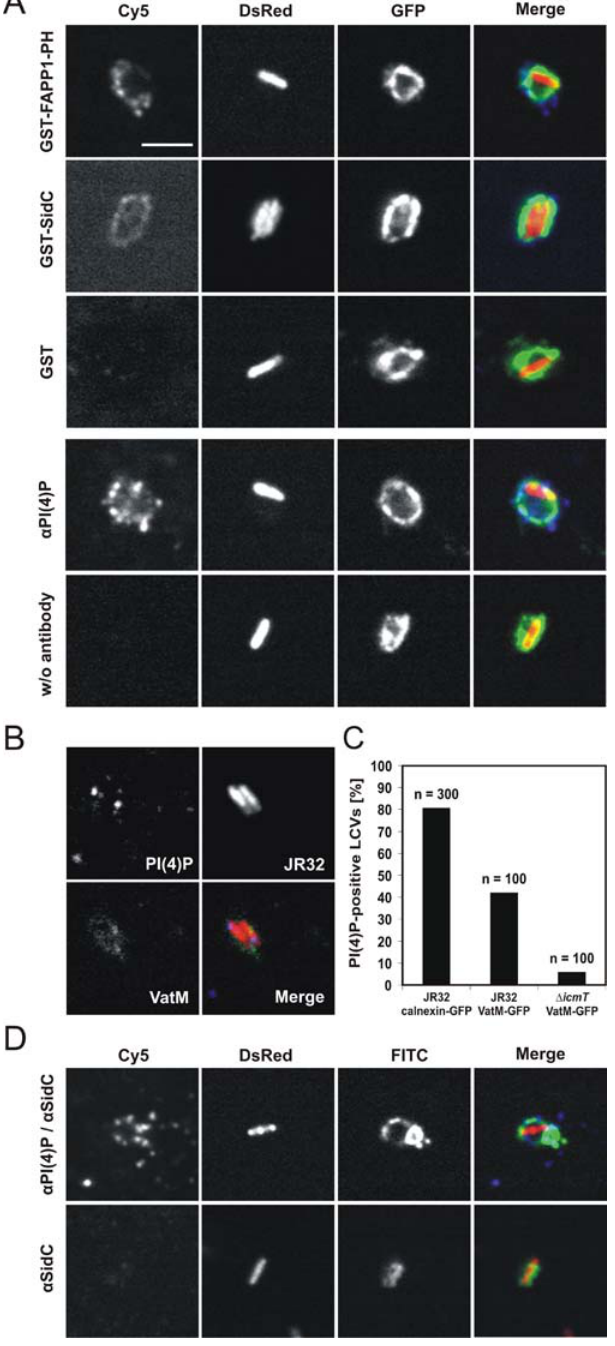
Figure 7. PI(4)P Is a Lipid Marker of LCVs Harboring Icm/Dot–Proficient L. pneumophila (A, B, and D) Confocal micrographs of LCVs in lysates of (A) calnexin-GFP– labeled Dictyostelium, (B) VatM-GFP–labeled Dictyostelium, or (D) RAW264.7 macrophages infected with DsRed-Express–labeled L. pneu- mophila are shown. The lysates were prepared with a ball homogenizer, and PI(4)P was visualized on the LCVs using as probes either the PH domain of the PI(4)P-binding protein FAPP1 fused to GST, an antibody against PI(4)P, or GST-SidC. Using GST alone or omission of the anti-PI(4)P antibody did not label the LCVs. Bar denotes 2 l m (magnification of all images is identical). (C) Quantification of PI(4)P-positive calnexin-GFP–labeled ( n ¼ 300) or VatM-GFP–labeled ( n ¼ 100) LCVs in Dictyostelium wild-type strain Ax3. DOI: 10.1371/journal.ppat.0020046.g007